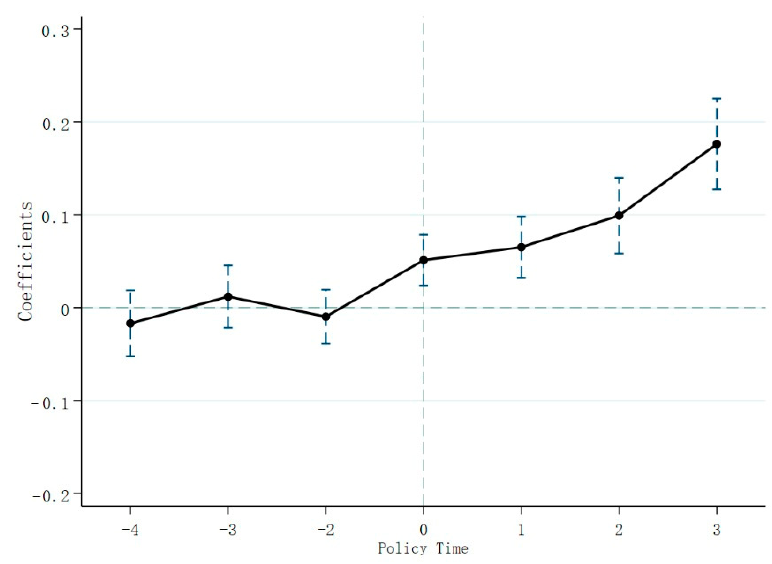
Figure 1. Parallel trend test.